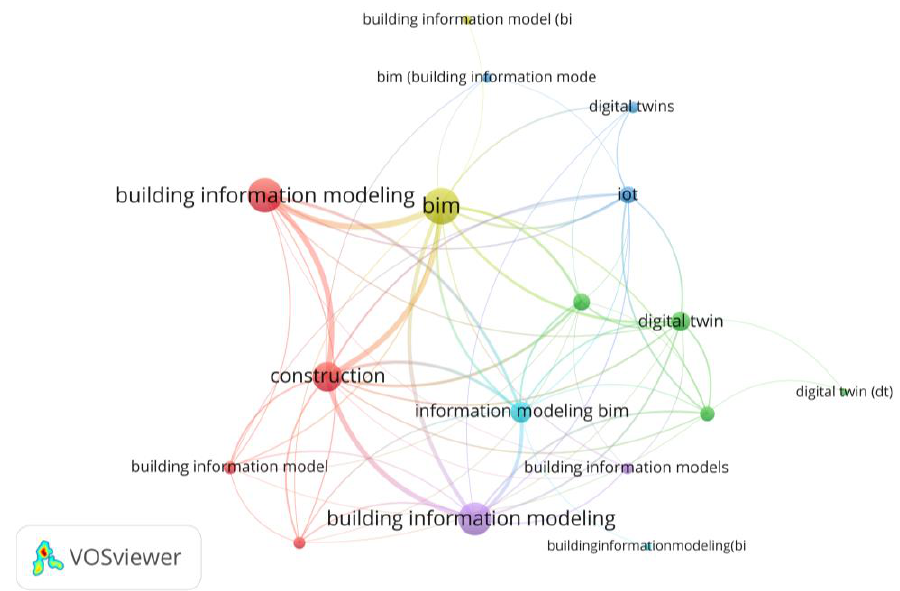
Figure 13. Network visualization of keyword co-occurrence of BIM, IoT, and DT in Construction.